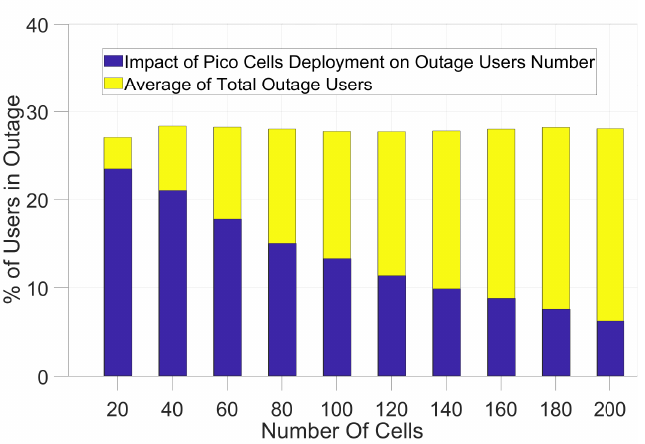
Figure 6. Simulation of macro-cell in the presence of Pico-cells with Path-loss model— Equation